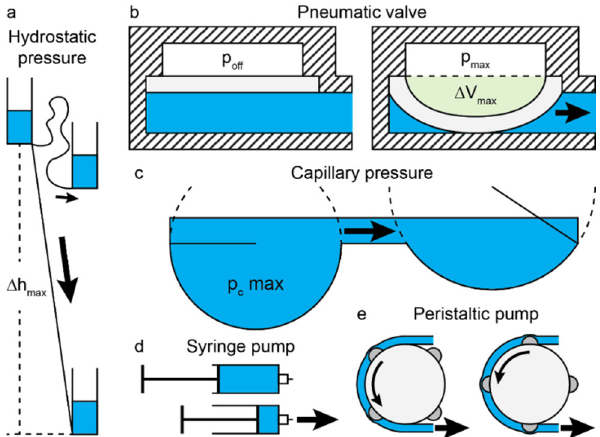
Figure 2. Typical fluidic sources. ( a ) Hydrostatic pressure driving flow, where maximum pressure is applied when the height difference is maximal ∆ h max —depending on the chip design. ( b ) Pneumatic driving of flow, where maximum fluid displacement ∆ V max is applied when the valve is actuated at its maximal pressure p max . ( c ) Capillary pressure driving flow, where maximum pressure p c max is applied when the surface curvature r min is minimal. ( d ) Syringe pump driving flow, where plunger leakage and syringe volume limit flow rate. ( e ) Peristaltic pump driving flow, where tubing compliance and volume limit flow rate.